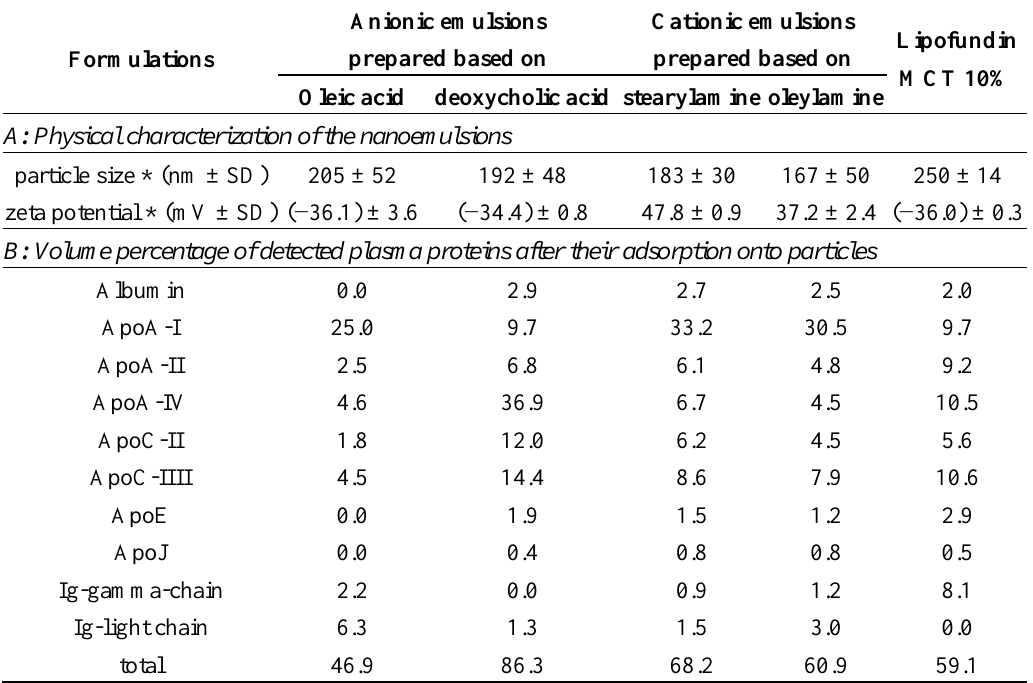
Table 1. Physical characterization of the nanoemulsions (* n = 3) and comparison of values (volume%) of adsorbed plasma proteins on surfaces of developed anionic and cationic emulsions and Lipofundin MCT 10% (after